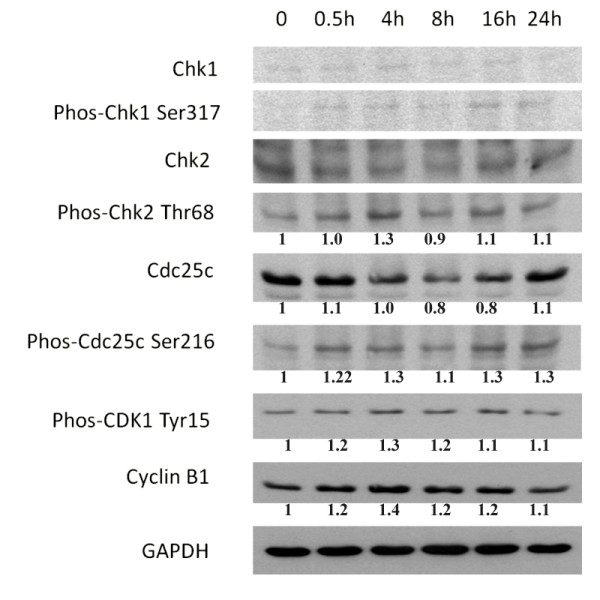
The expression of mitosis arrest-related proteins after costunolide treatment in hepatoma cells. Lane 1, untreated control; lane 2 - 6, treated with 5 μM costunolide for various time points.